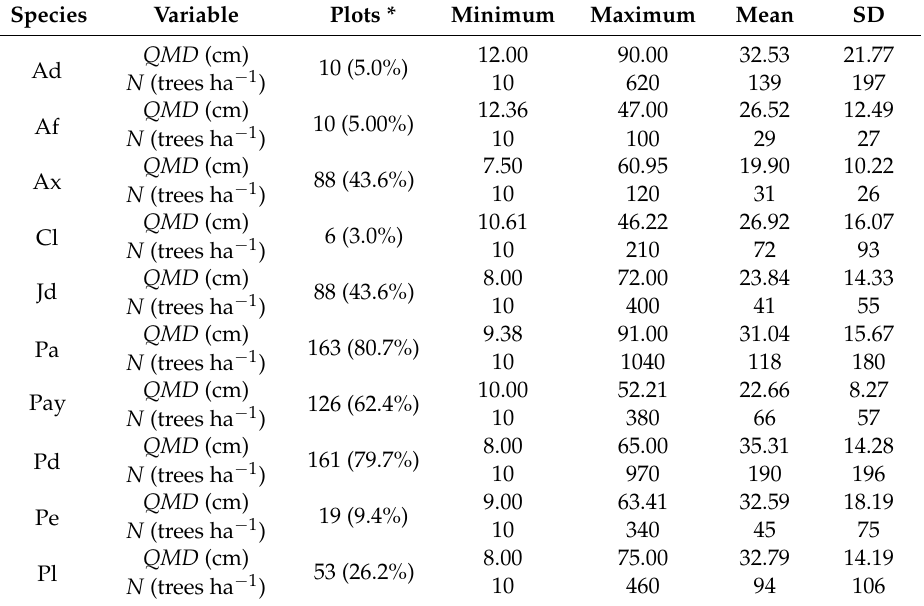
Table 2. Descriptive statistics of the dataset by species for mixed-species